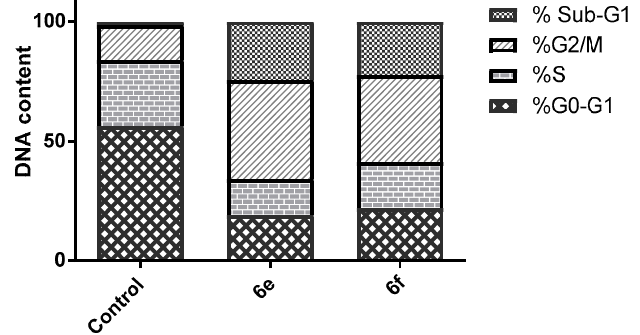
Figure 2. Impact of conjugates 6e and 6f on the cell cycle phases of MCF-7 cells.